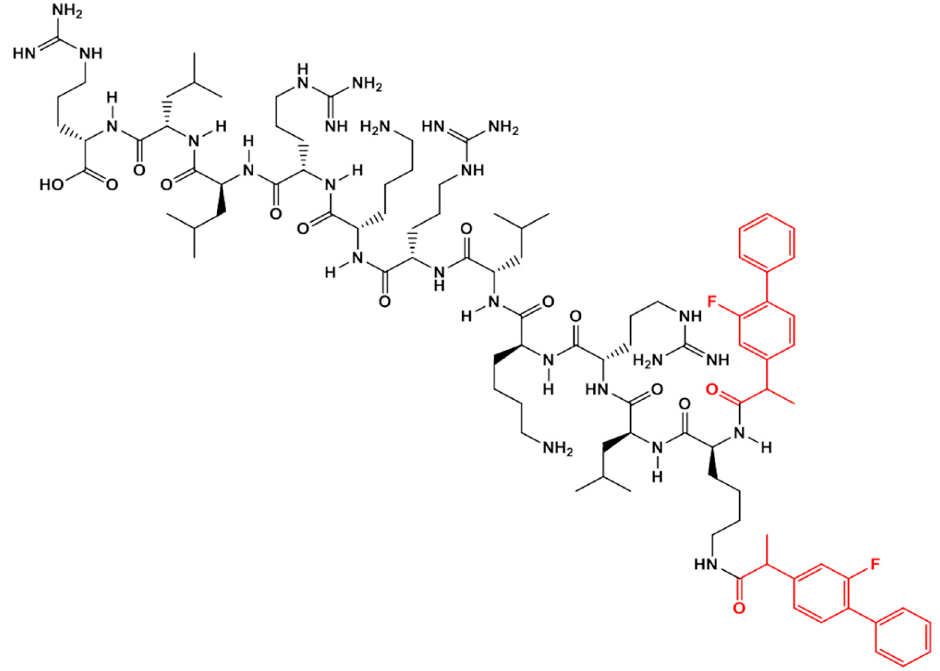
Figure 1. Chemical structure of the drug delivery system (AEP-K-FP) (obtained by ChemDraw Professional 15, PerkinElmer, South Carolina, US).